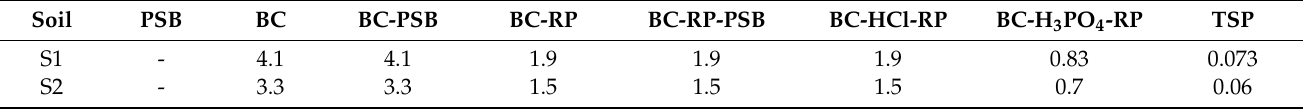
Table 2. Amounts of phosphate fertilizer forms used (g P/100